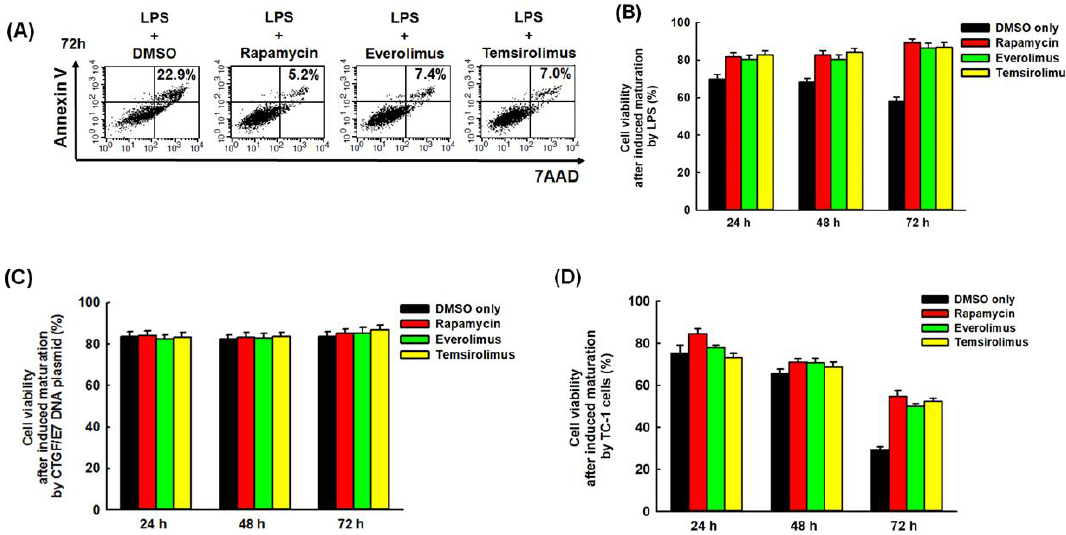
Figure 3. Anti-apoptotic effects of mTORi on mature BMM-derived DCs. ( A ) Representative